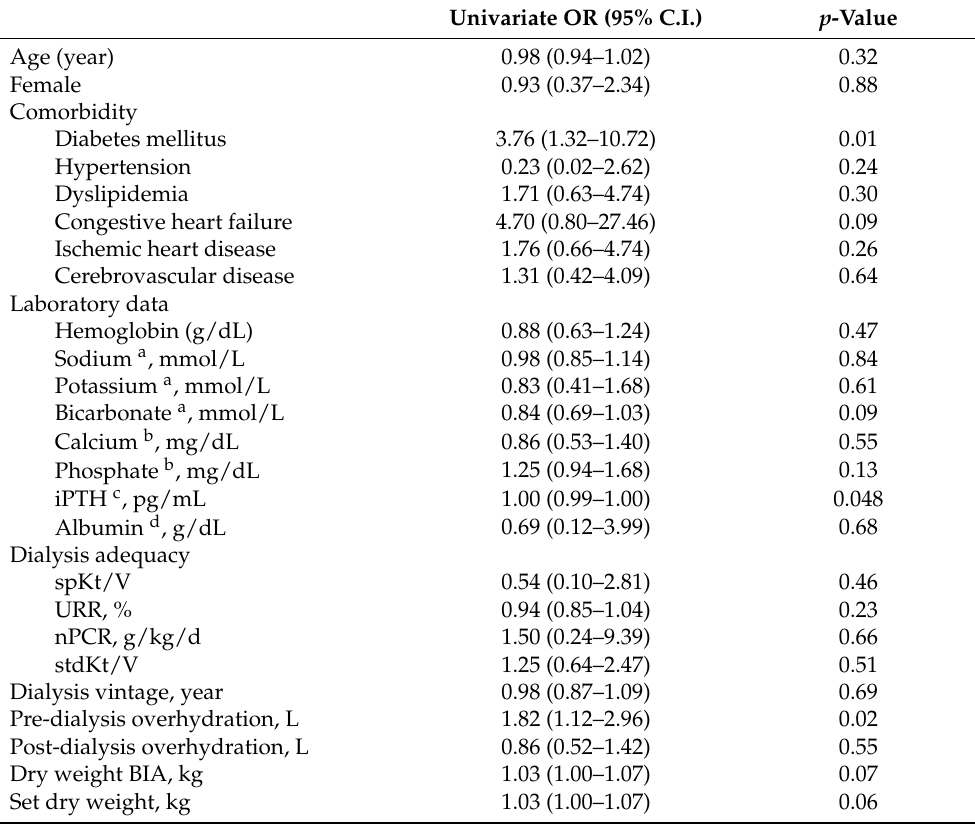
Table 2. The univariate analyses for unsuccessful reductions in hemodialysis frequency. Univariate OR (95%